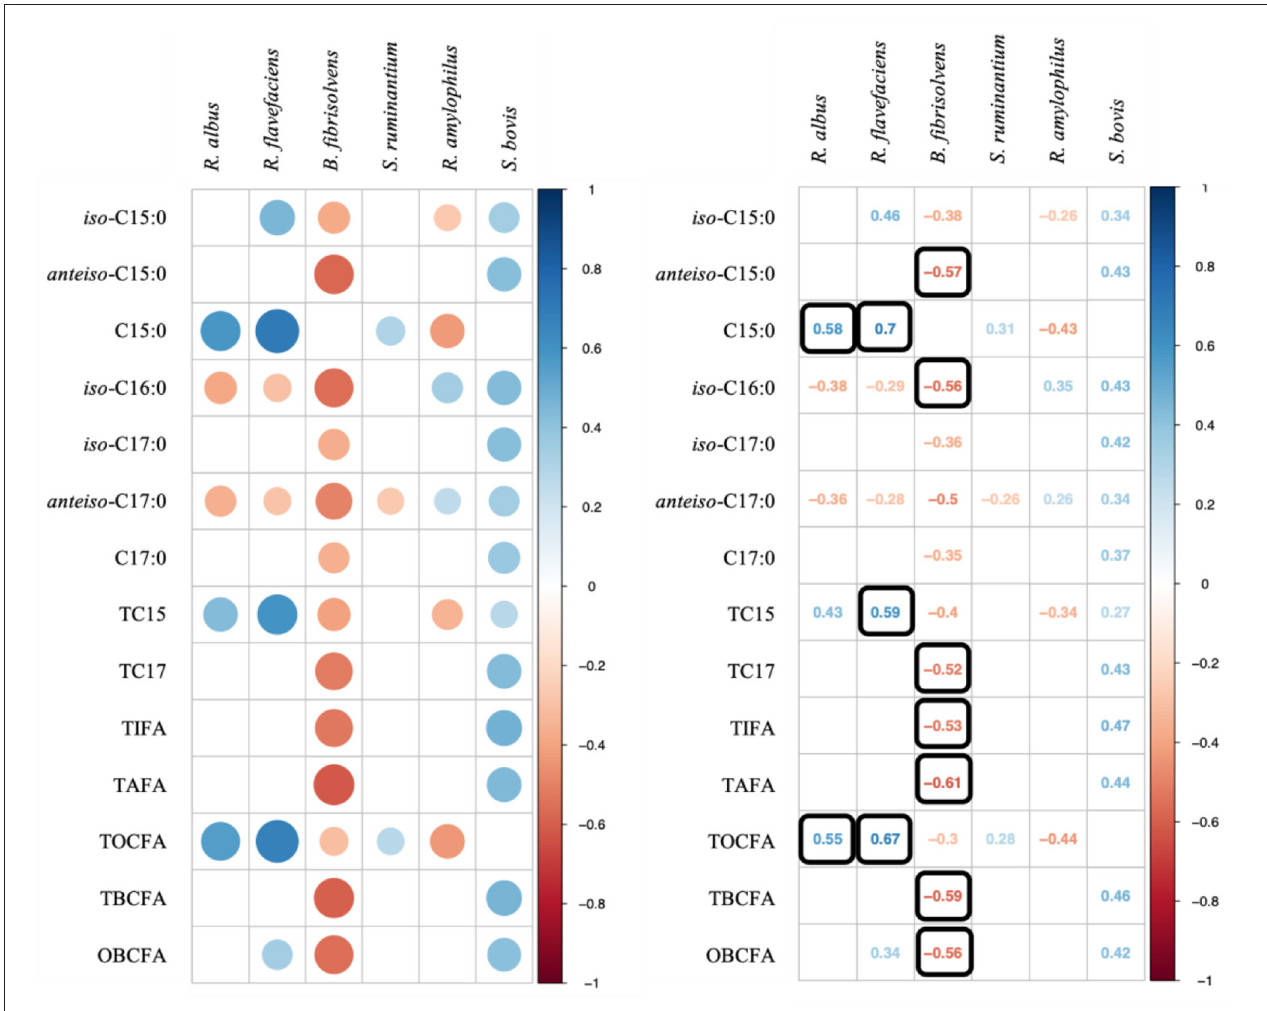
FIGURE 2 | Correlation analysis on ruminal bacterial populations and OBCFA concentrations during 24h of incubation in vitro . Color in Q22 round shape represents significant correlations ( P < 0.05) and black square means − 0.50 > ρ >